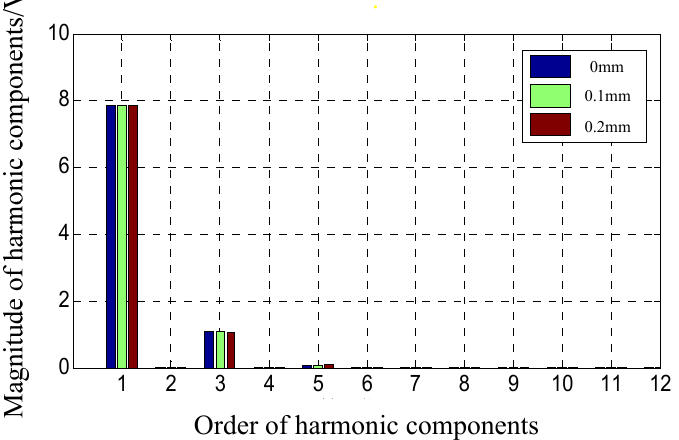
Figure 15. Comparison of harmonic components of EMF with skew in a variable period.